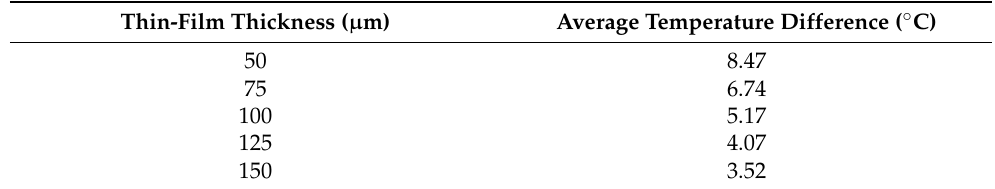
Figure 10. Temperature change of the hot junction under different thin-film thicknesses. Table 3. Average temperature difference of the hot junction under different thin-film thicknesses.